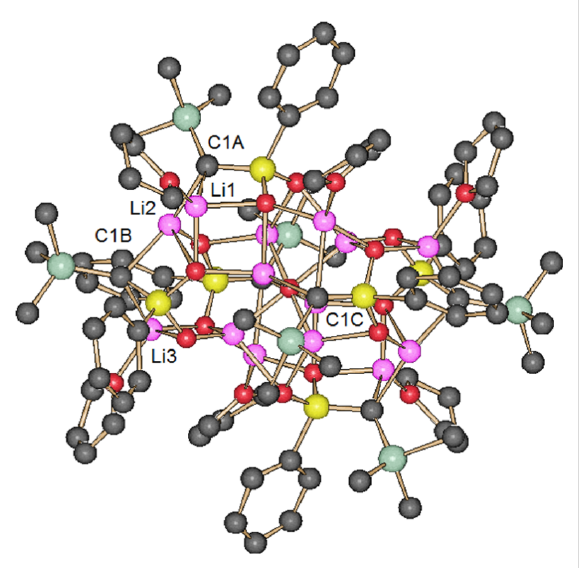
Figure 5: the structure of ( 2a ) 6 ·Li 2 O·(THF) 6 in the crystal [15]. Color code: black, C; green, Si; yellow, S; red, O; pink, Li. Hydrogen atoms are omitted for clarity. Selected bond distances (pm) and dihedral angles (°): C1A–Li1 218, C1A–Li2 225, C1B–Li2 219, C1B–Li3 234, C1C–Li7 223, C1C–Li4 251, C1C–Li6 283, C2A–S–C1A–Si 50, C2B–S–C1B–Si 12, C2C–S–C1C–Si